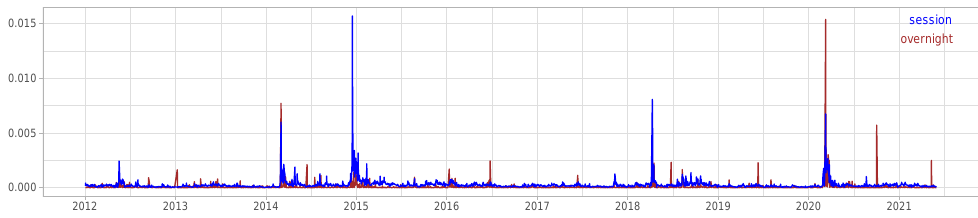
Figure 1. Realized and overnight volatility for